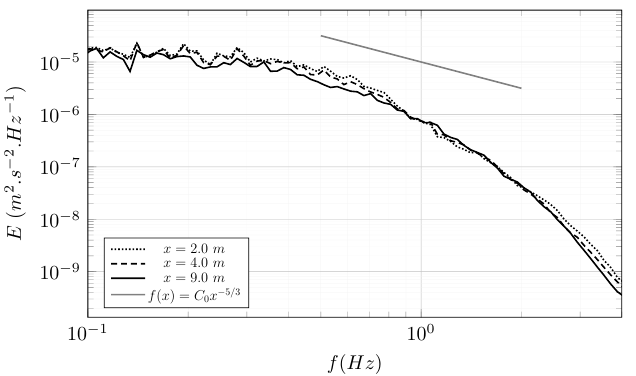
Figure 12. Power spectral density calculated from the stream-wise velocity component computed from a LBM-LES simulation using DFSEM with L = 1.0 m and u (cid:48) 2 distance from the inlet of the LBM